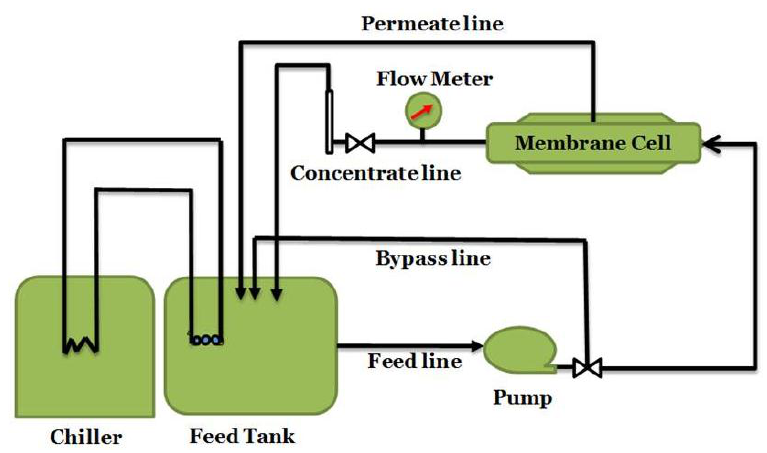
Figure 13. Schematic illustration of forward cross flow filtration system.